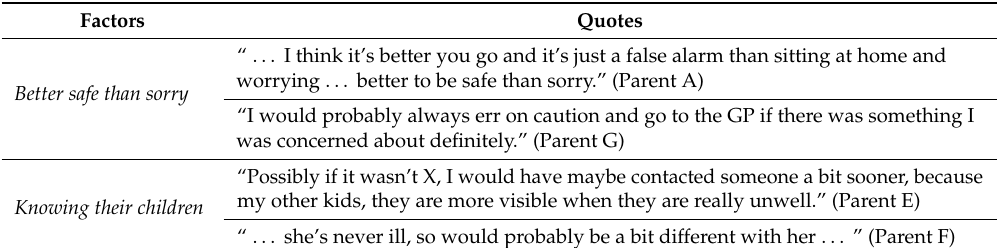
Table 1. Quotes from parents of children admitted with an acute medical condition relating to some of the factors which may influence their decision to seek medical